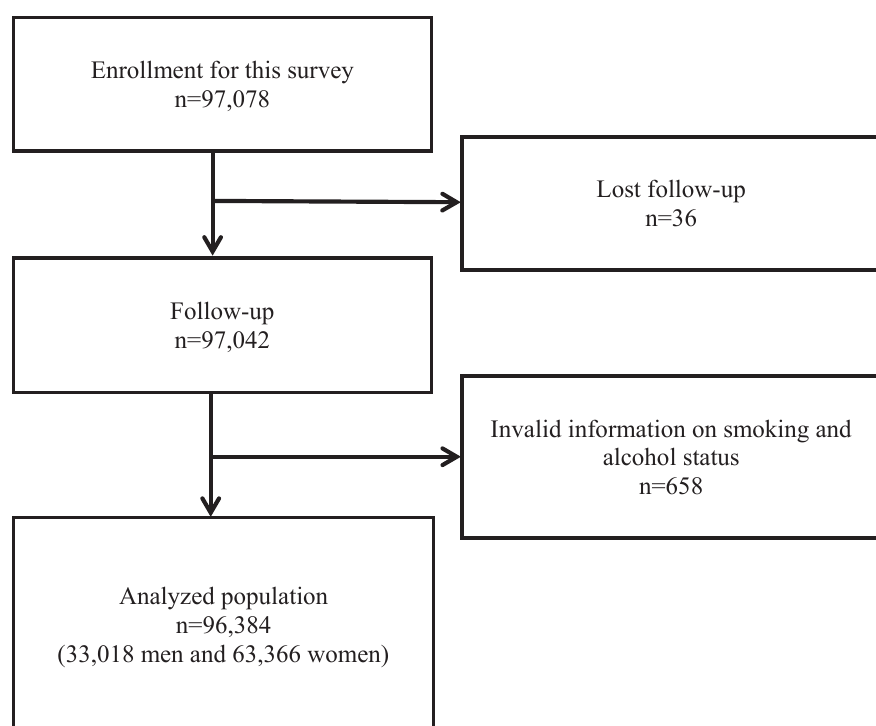
Figure 1. Participant fl ow diagram from the Ibaraki Prefectural Health